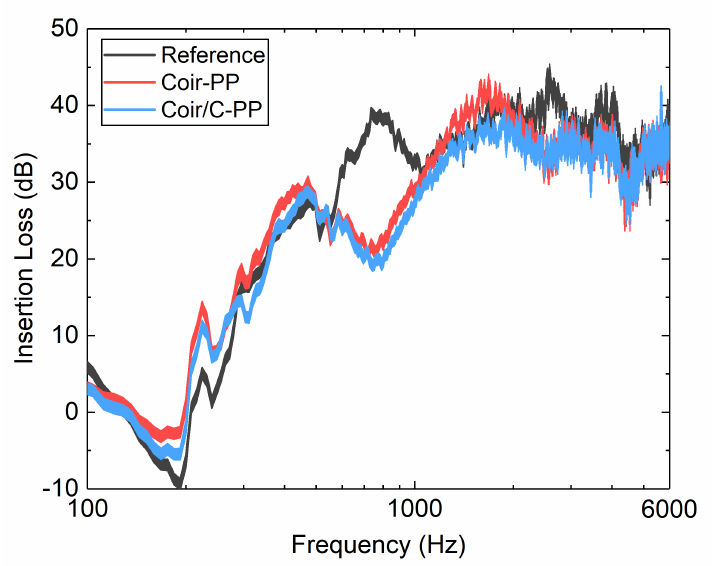
Figure 6. Insertion loss curves of the reference earmuff (dark grey), the Coir-PP earmuff (red), and the Coir/C-PP earmuff (blue) in aircraft take-off exterior noise. Shaded area is bounded by the upper and the lower limits of the expanded uncertainty at a confidence level of 95%. Note that the frequency interval is 8